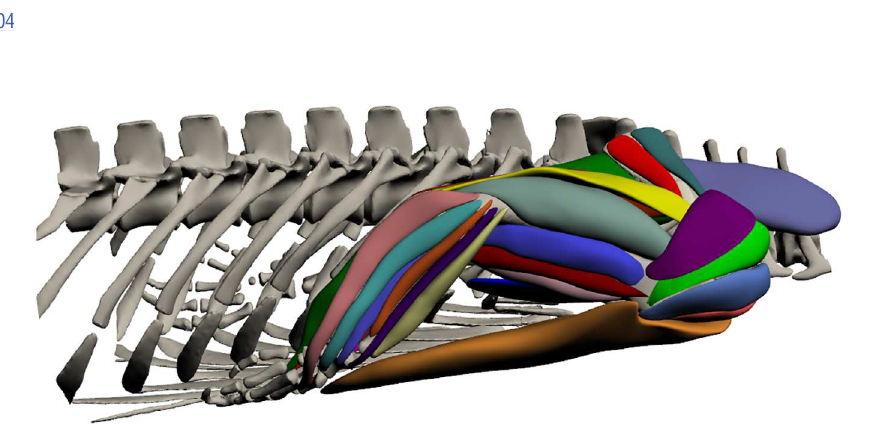
Fig 5. Three-dimensional model of forelimb musculature in Crocodylus porosus . Lateral view of the right forelimb. The interactive version of this model is availablein ‘Supplementary Information’.